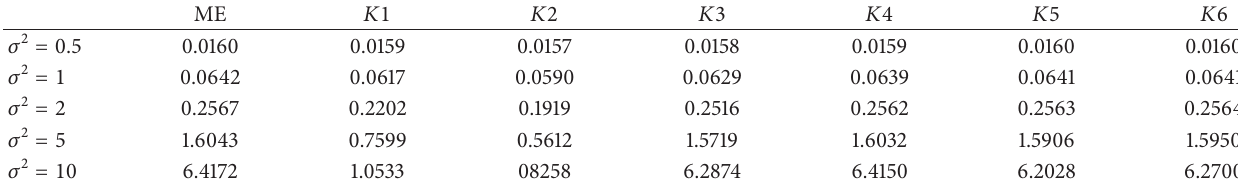
Table 7: Estimated MSE with 𝑛 = 100 , 𝑝 = 4 , and 𝛾 = 0.95 .